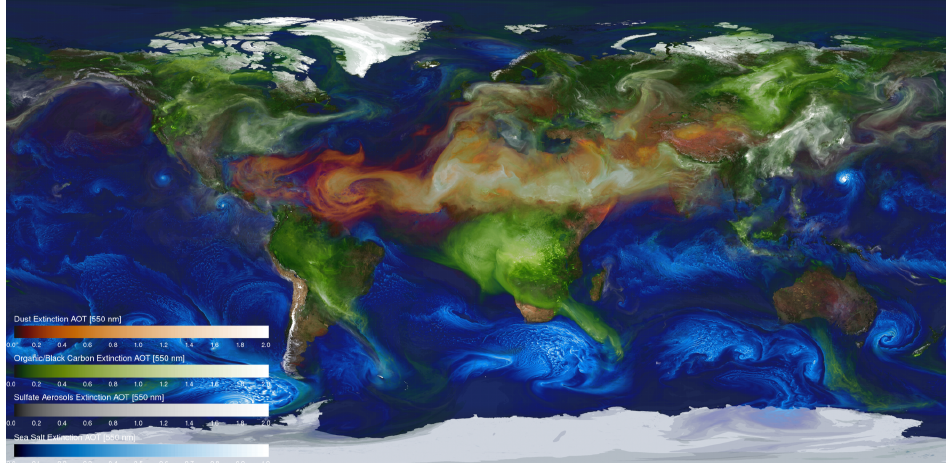
Figure 2. The 7 km G5NR aerosol simulation for 27 July 2006 at 12 Z. Blue shading corresponds to sea salt concentration, green shading corresponds to black and organic carbon concentrations, red-orange shading corresponds to dust, and white shading corresponds to